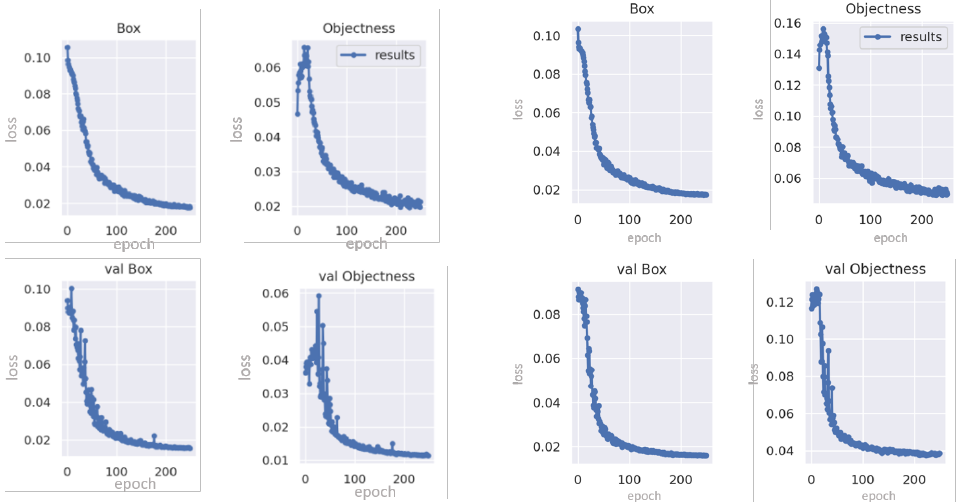
Figure 6. Loss during training, related to both the predicted bounding box and the loss related to the given cell containing an object, as well as their validation scores displayed as Box and Objectness. Results for the YOLOv5s are on the left hand side, for the YOLOv5m at the right hand side.